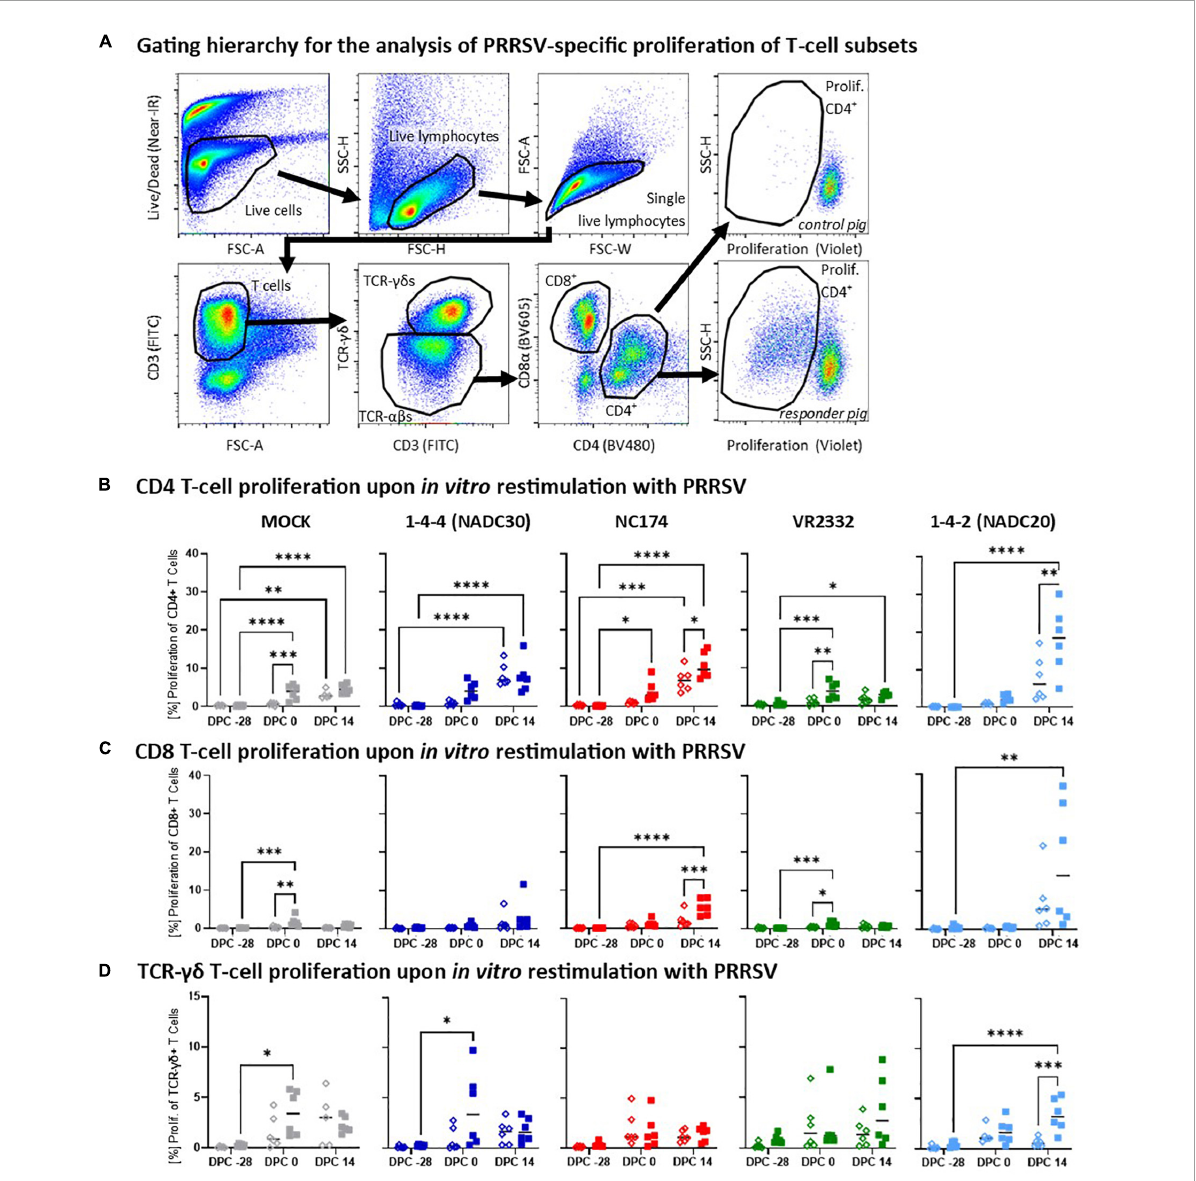
FIGURE5 Heterologous vaccine immunogenicity—proliferation of CD4, CD8, and TCR- γδ T cells. Panel (A) shows the gating hierarchy to assess the heterologous proliferative response of T-cell subsets to the respective PRRSV type-2 challenge strains. A live/dead discrimination dye was included to exclude dead cells. Live cells were used to identify live lymphocytes via a FSC/SSC lymphocyte gate. From live lymphocytes, doublets were excluded using a FSC-width (FSC-W)/FSC-area (FSC-A) gate on singlets. These single living lymphocytes were used to gate on T cells (FSC-A/CD3), and further to discriminate TCR- αβ and TCR- γδ T cells. TCR- αβ T cells were further divided into CD4 and CD8 T cells via their CD4/CD8 α expression profile. Proliferation of the CD4, CD8, and TCR- γδ T cells was identified via a violet proliferation dye. Two examples demonstrate representative staining patterns of a control animal (top right plot) and a high responder animals (bottom right plot). Panels (B–D) show the proliferative responses of CD4 (B) , CD8 (C) , and TCR- γδ T cells (D) according to their challenge groups—MOCK (gray), NC174 (red), NADC20 (light blue), NADC30 (dark blue), and VR2332 (green). The black bars represent the median values; in addition, individual data points are shown for MOCK vaccinated animals (open diamonds) and MLV vaccinated animals (filled squares). Data were statistically analyzed using a 2-way ANOVA with time and vaccination as the two parameters and Tukey’s multiple comparison test. ∗∗∗∗ p < 0.0001, ∗∗∗ p < 0.001, ∗∗ p < 0.01, ∗ p < 0.05.